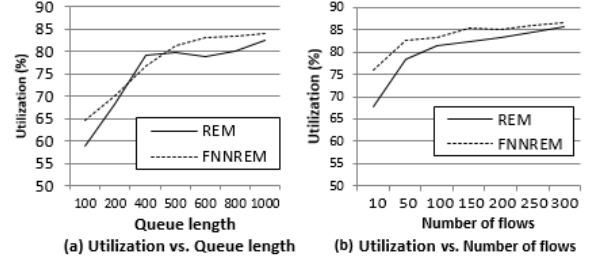
Figure 13. Utilization of the transmission of active queue management mechanism